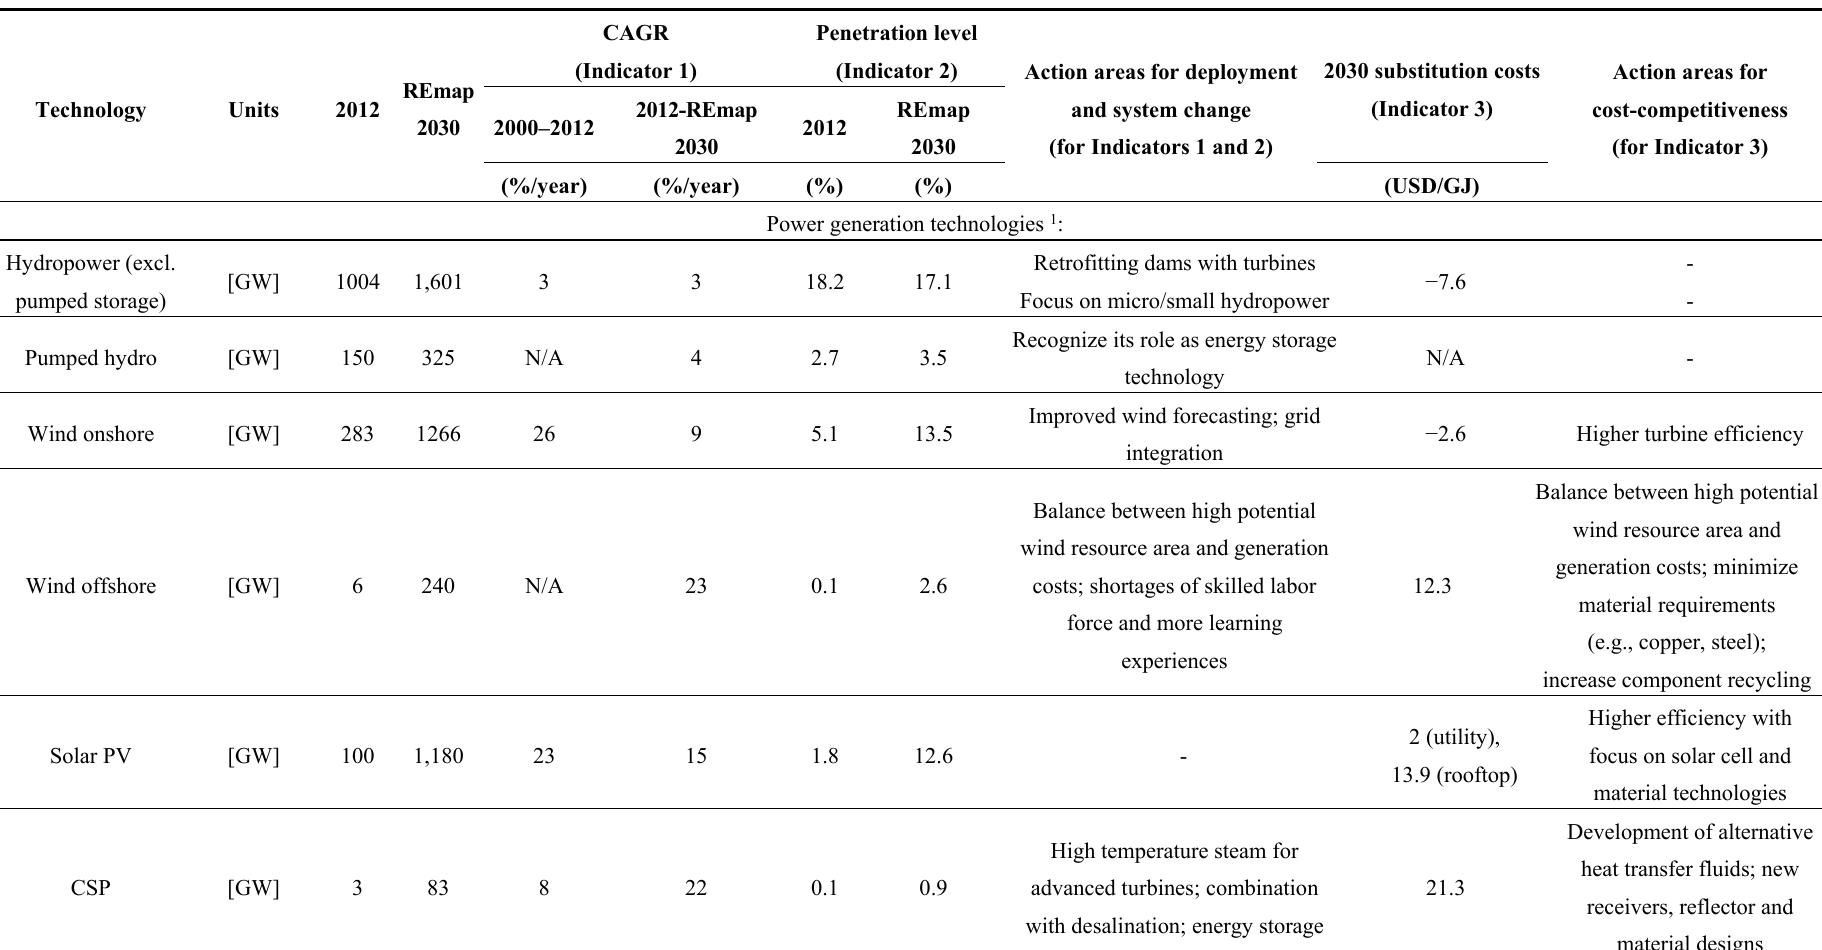
Table 5. Global installed capacity, deployment expressed as compound annual growth rate and penetration level between 2012 and REmap 2030, substitution costs of RE technologies in year 2030 and identified action areas for deployment, system change and cost-competitiveness.